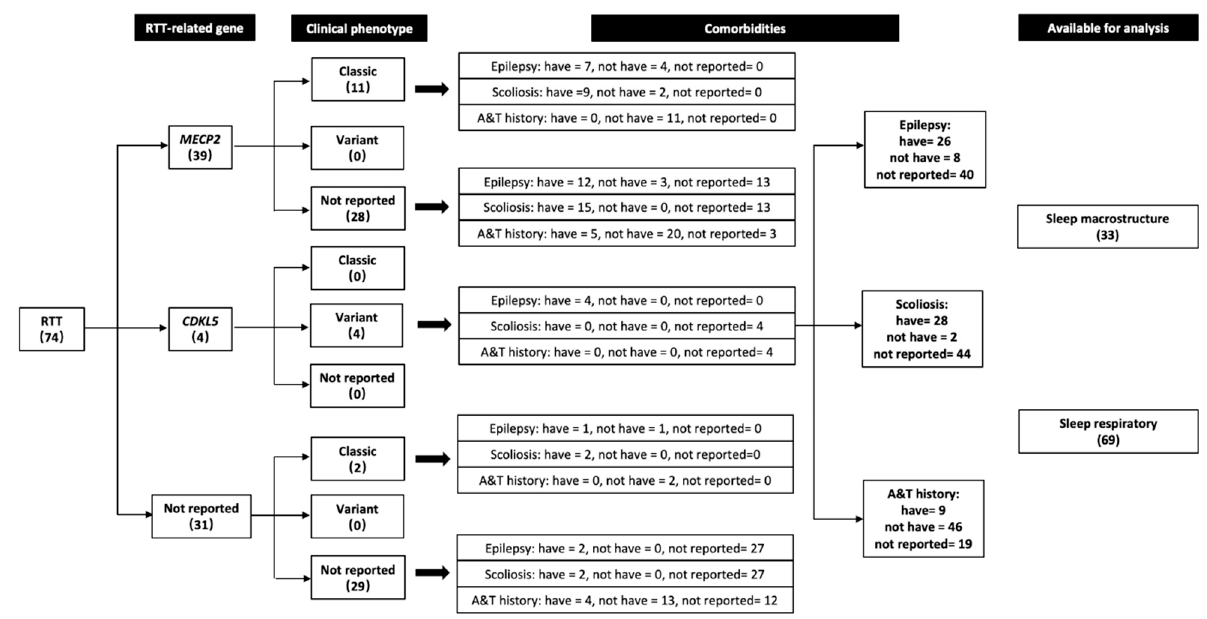
Figure 2. Number of cases in stratification analysis. A & T: adeno(tonsil)ectomy surgery; CDKL5 : cyclin-dependent kinase-like 5; MECP2 : methyl-CpG-binding protein-2; RTT: Rett syndrome.